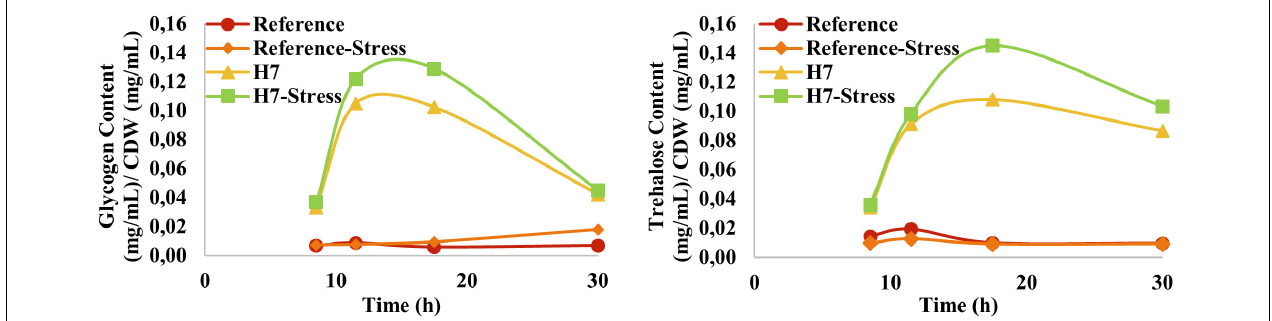
FIGURE 7 | Glycogen and trehalose production (mg mL − 1 ) per CDW (mg mL − 1 ) profiles of the reference strain and H7 in the absence and presence of 0.5-mM H 2 O 2 as the oxidative stress factor. The cultures were grown at 30 ◦ C and 150 rpm, using YMM. Glycogen and trehalose contents of the samples were determined enzymatically, between the 10th and 30th hour of cultivation.